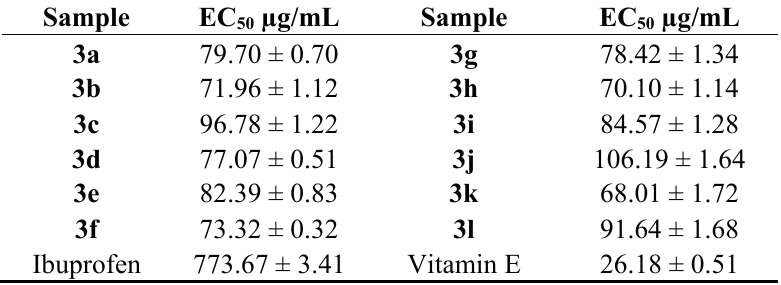
Table 2. Total antioxidant activity (EC 50 µg/mL) of the acylhydrazone derivatives 3a – l .